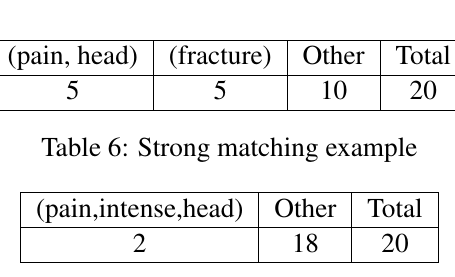
Table 7: More detailed query using strong matching